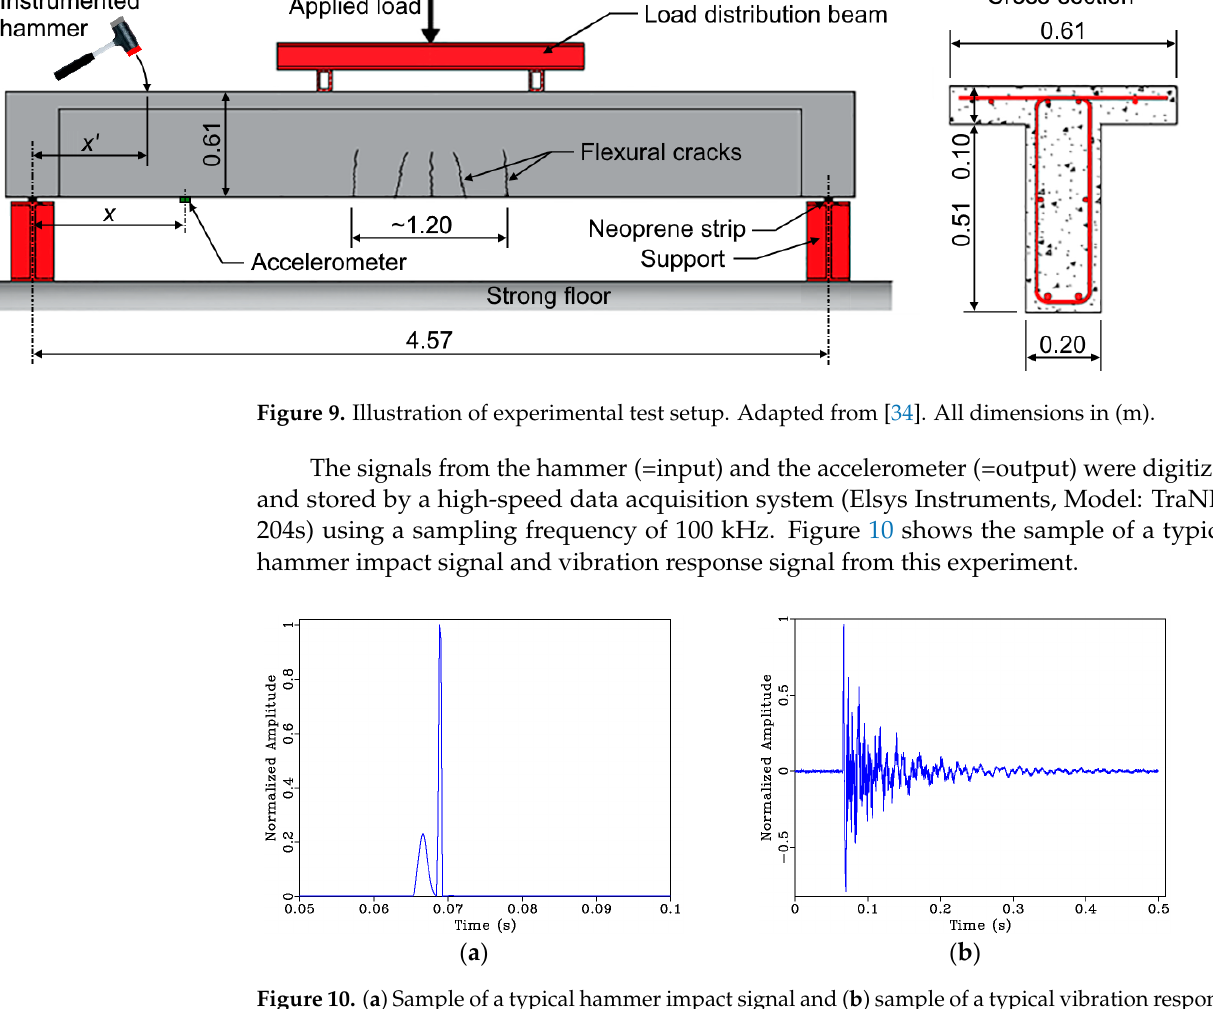
Figure 10. ( a ) Sample of a typical hammer impact signal and ( b ) sample of a typical vibration re- sponse signal.